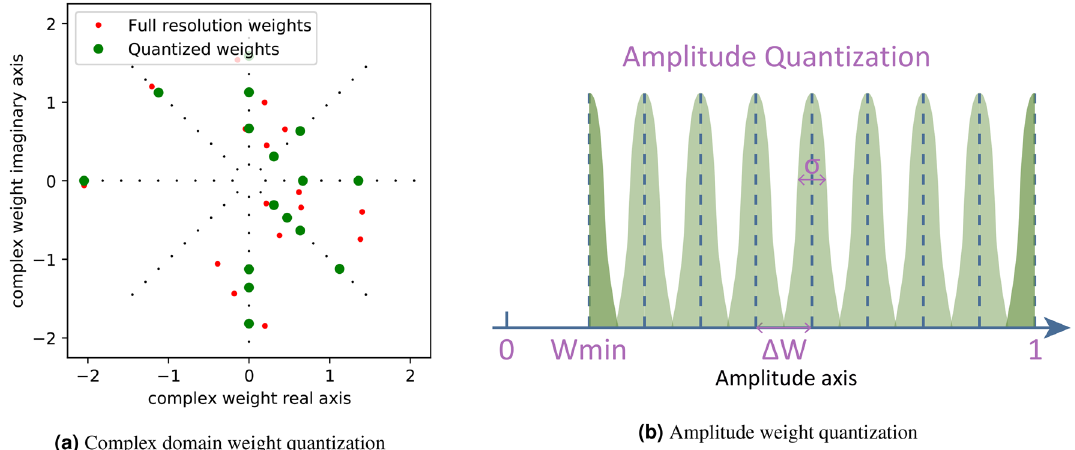
Figure 2. ( a ) An illustration of complex weights quantization in a coherent photonic readout system. Small black dots are all available quantization weights in the complex plane. Red dots represents the pre-trained full resolution weights, Green dots are corresponding quantized weights. Weighting noise in this figure is set to 0. ( b ) An illustration of amplitude quantization model for a general optical weighting element. The green shadowed areas represent noise probability